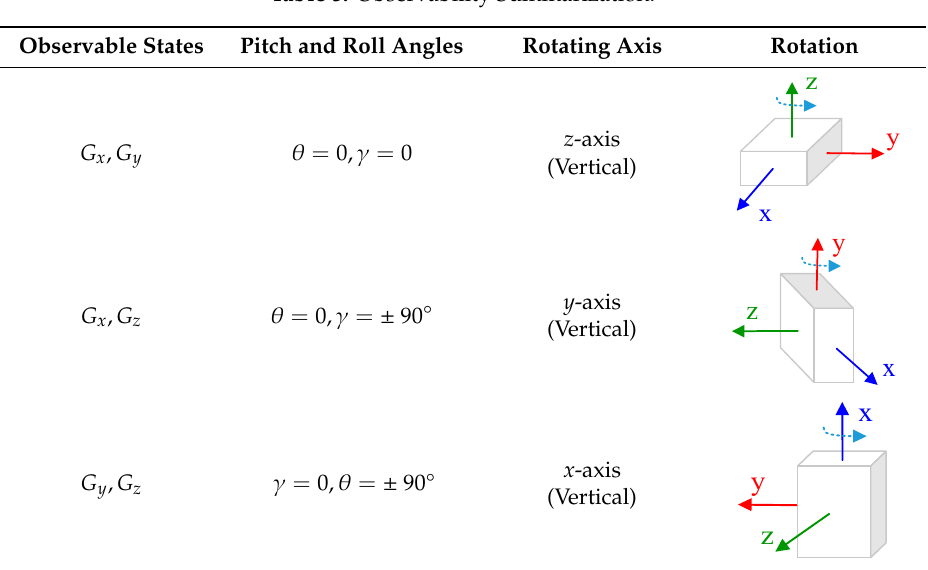
Table 5. Observability Summarization.